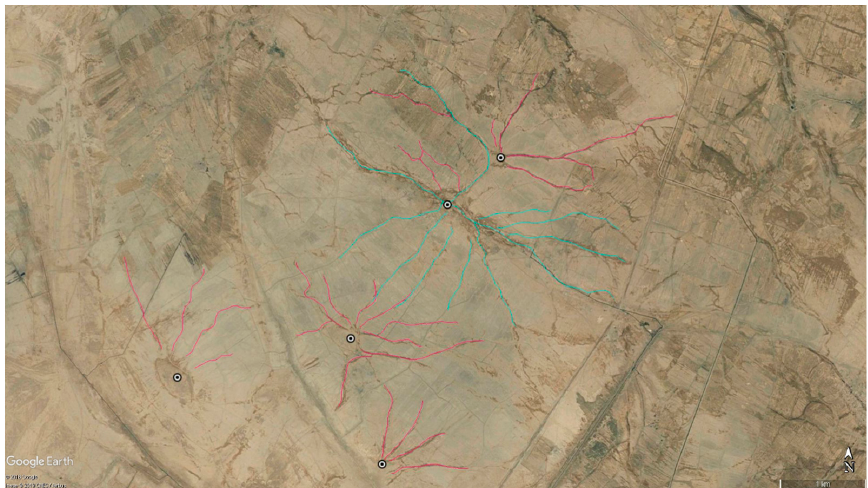
Figure 6. Complicating identification, some hollow ways have been re-used as water channels. In this image, the pink lines show confirmed hollow ways, while the blue lines are presently water channels. In this example, the water channels are relatively recent and conversation with local informants revealed that they chose to dig these water channels following pre-existing depressions they observed in the landscape.